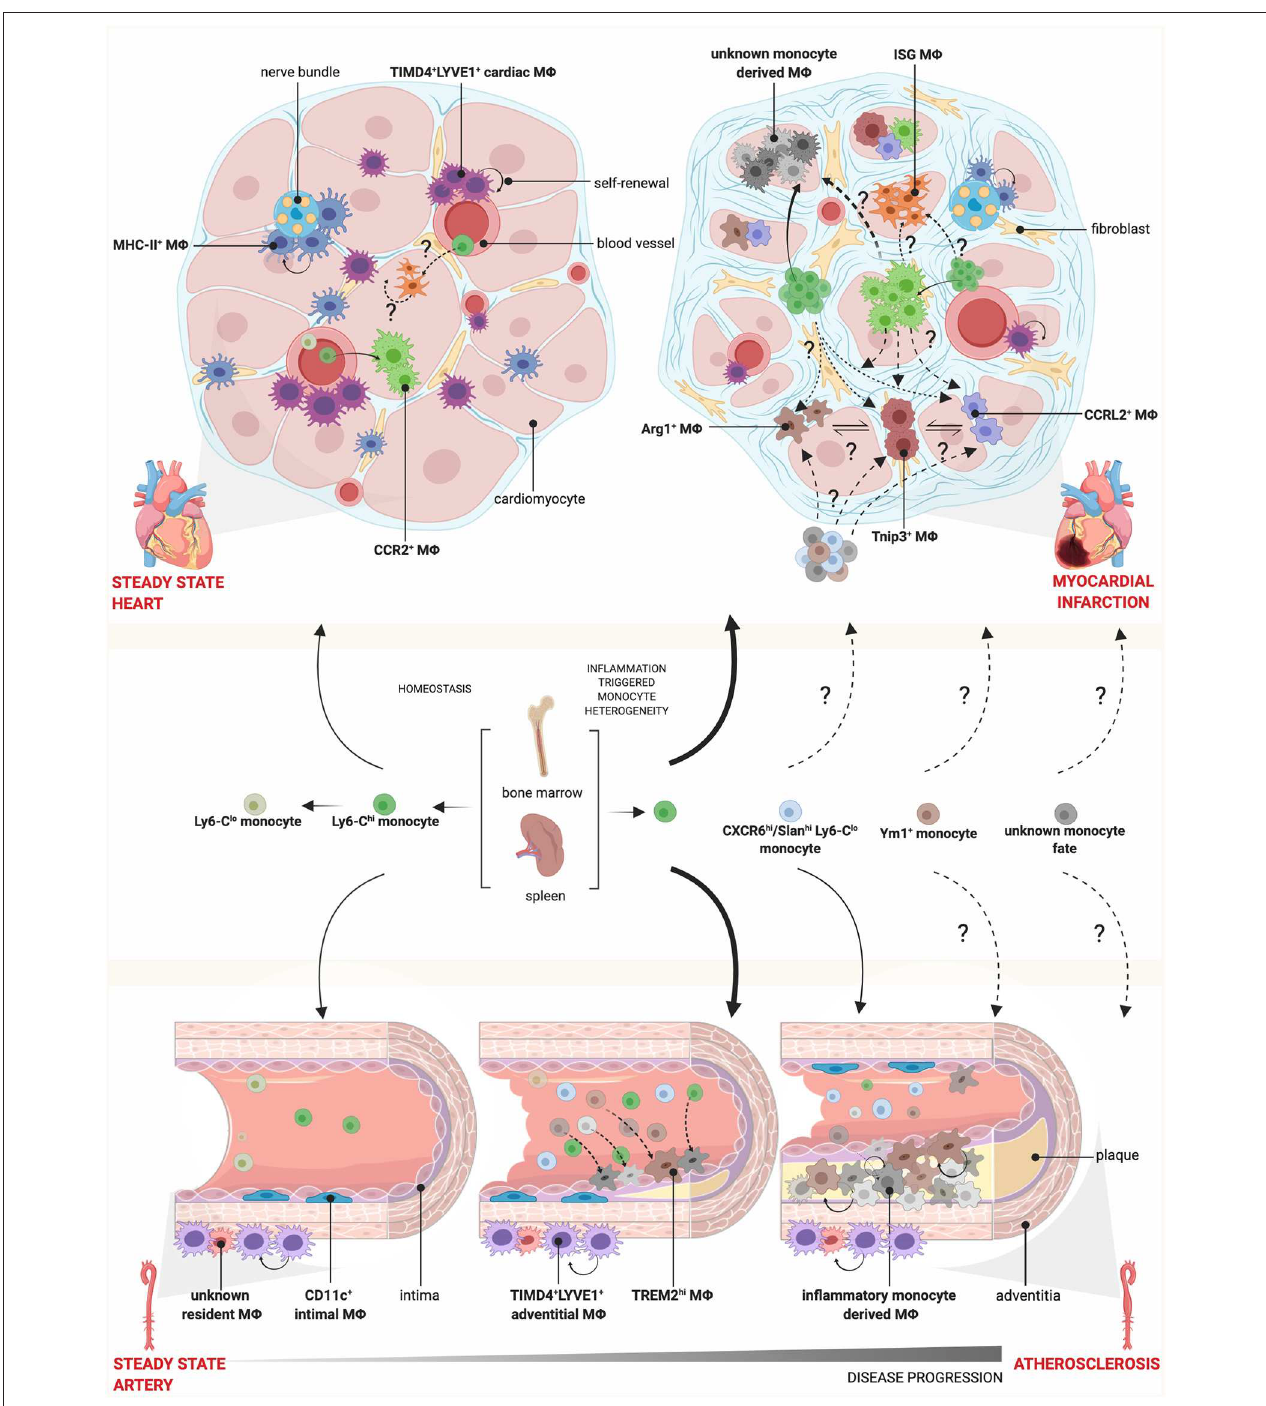
FIGURE 1 | Monocyte and macrophage heterogeneity in steady state and cardiovascular disease. During homeostasis, Ly6C hi monocytes circulate through blood vessels and infiltrate tissue, where they give rise to CCR2 + M 8 s, while Ly6C lo monocytes patrol the vasculature. Cardiac M 8 s are further composed of monocyte-independent self-renewing TIMD4 + LYVE1 + and MHC-II + resident M 8 s, which localize preferentially near blood vessels and nerve bundles, respectively. During myocardial infarction, there is increased monopoiesis and release of Ly6C hi monocytes from the spleen and bone marrow, which are recruited to the injured heart and give rise to diverse M 8 subsets. Whether these M 8 subsets are a spectrum of activation states or arise via pre-defined monocyte fates, such as Ym1 + or CXCR6 hi /Slan hi Ly6C lo monocytes as identified in other disease models, is not known. Conversely, there is a loss of TIMD4 + LYVE1 + and MHC-II + resident M 8 s. In the vessels, the intima is lined with CD11c + M 8 s and the adventitia contain TIMD4 + LYVE1 + M 8 s and other undefined resident M 8 populations. In atherosclerosis, TREM2 hi M 8 s and inflammatory monocyte-derived M 8 s accumulate in the intima, expand via self-renewal and participate in plaque growth. How this fate is defined and the contribution of CXCR6 hi /Slan hi Ly6C lo monocytes, found in the circulation of patients correlating with disease severity, is unknown. M φ , macrophage.